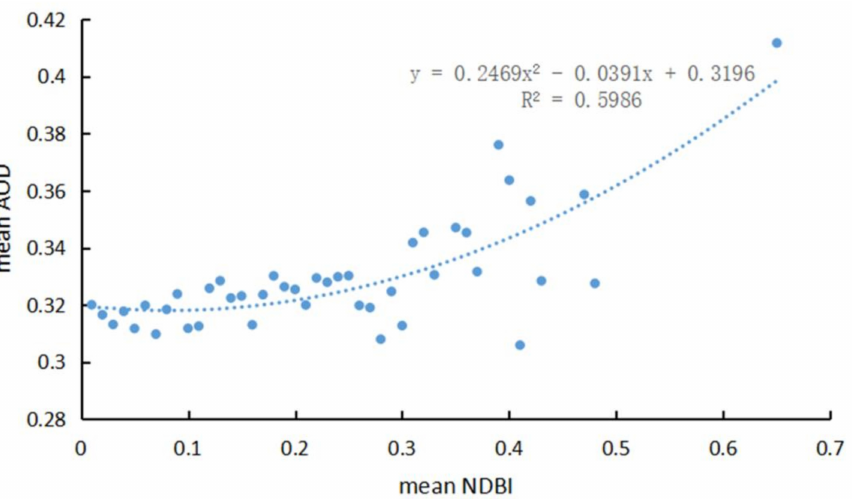
Figure A2. Relationship between NDBI (Normalized Difference Built-up Index) and associated AOD (Aerosol Optical Depth) values in the NDBI range of 0 to